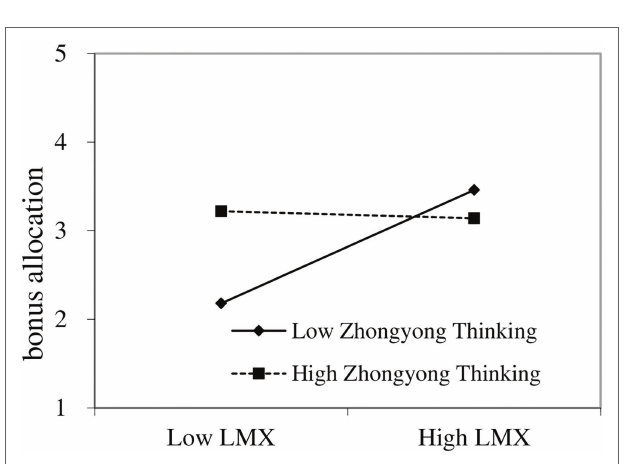
FIGURE 4 | Moderating role of ZYT in the relationship between LMX and bonus allocation.